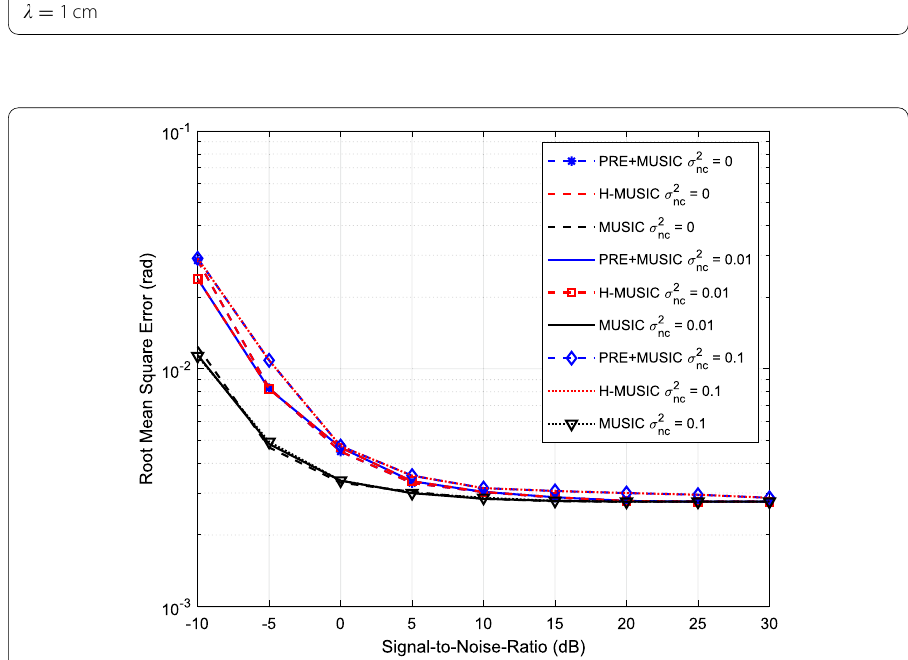
Fig. 6 RMSE of AoA estimation for the fully connected architecture, M c = 500 , S 1 = 20 , S 2 = 80 , (cid:31) =